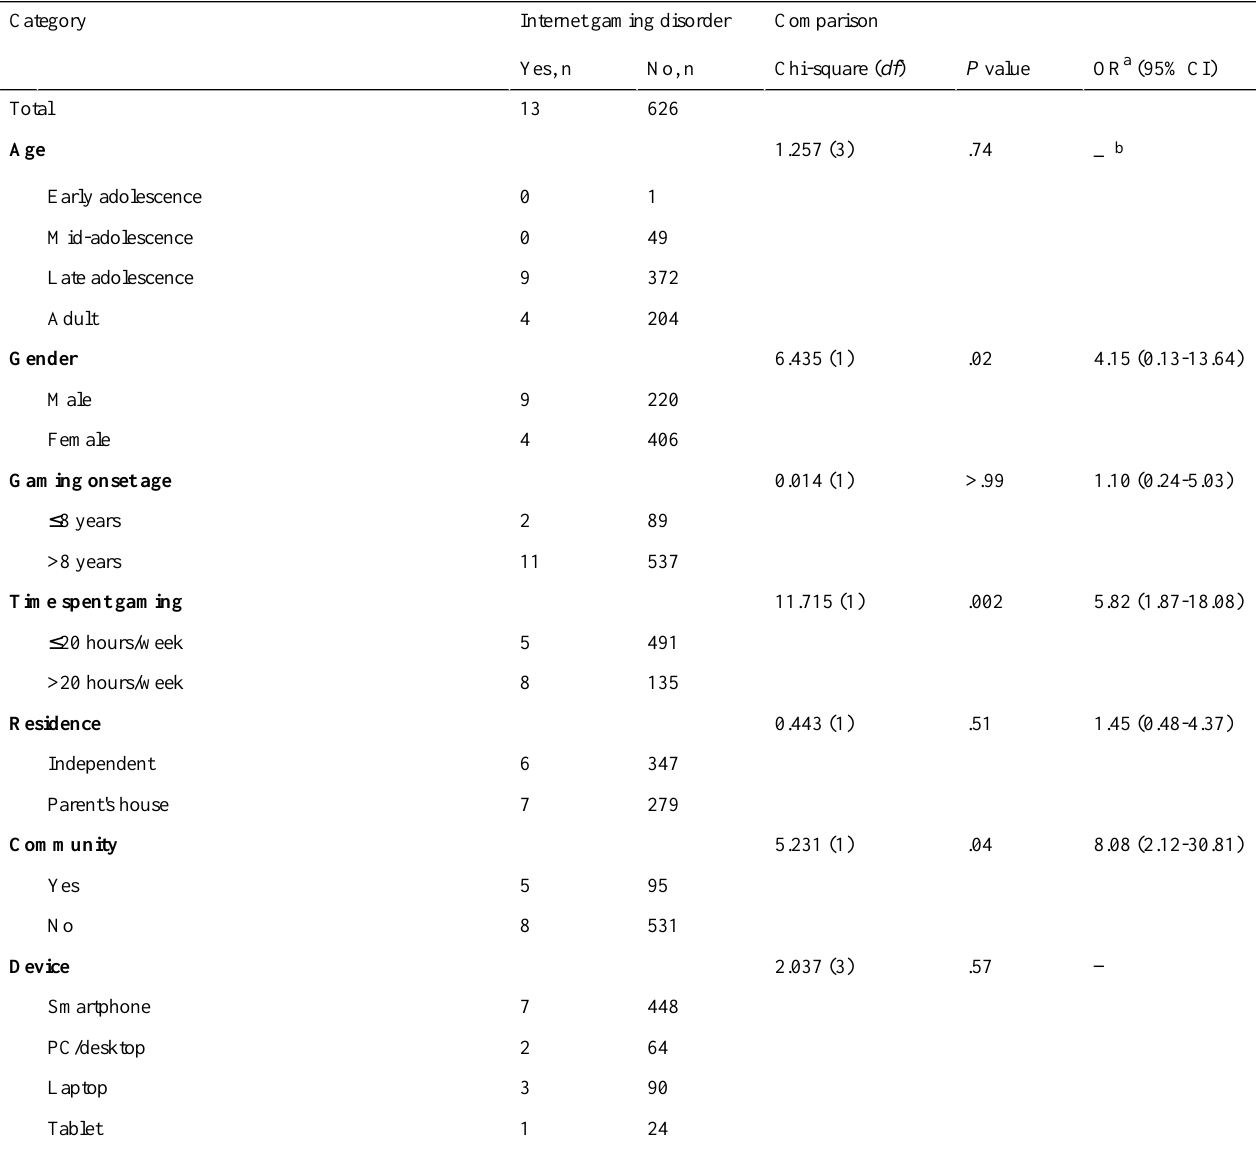
Table 2. Comparison of demographics between respondents with and without internet gaming disorder. ComparisonInternet gaming